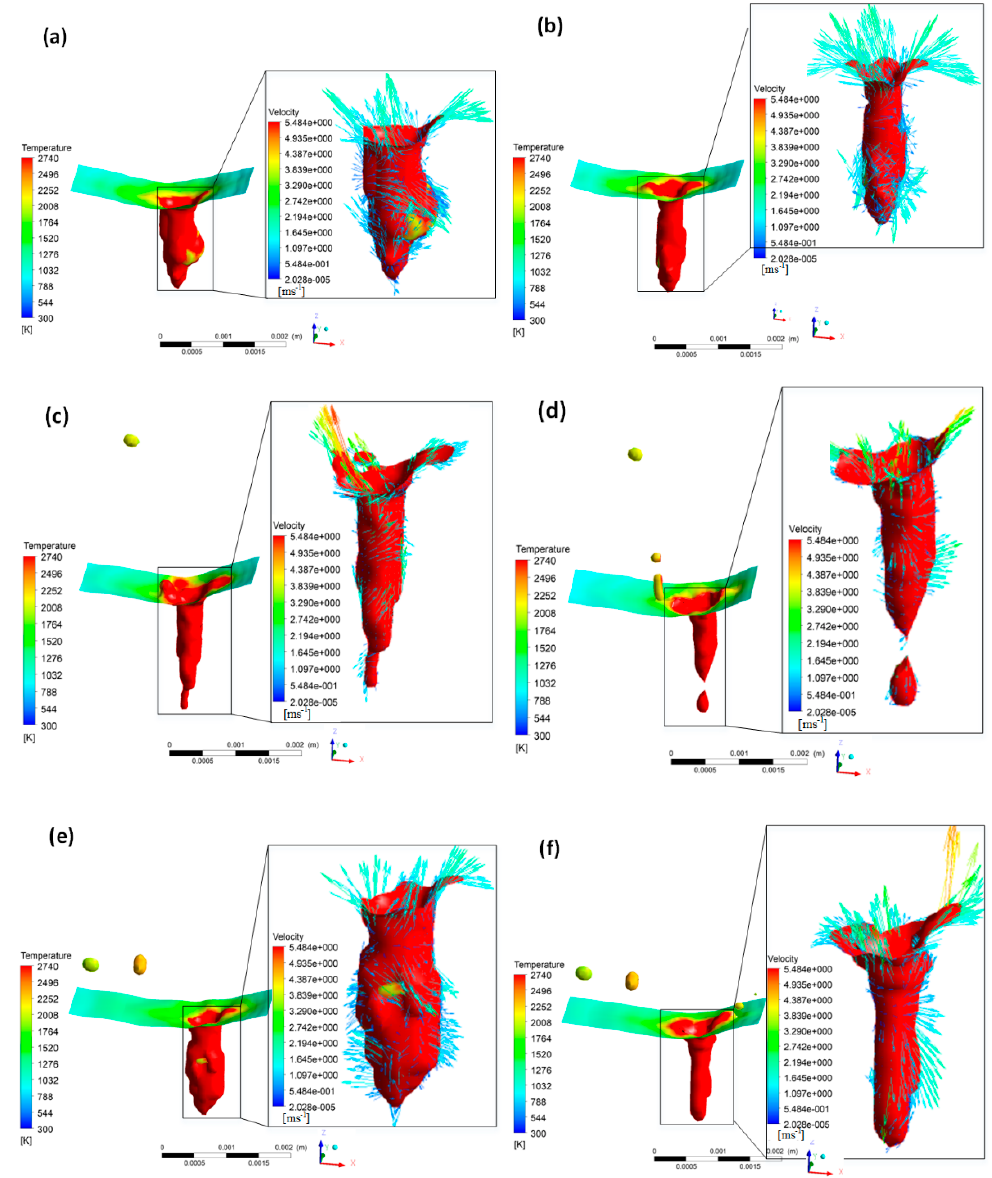
Figure 3. Three-dimensional transient behavior of the keyhole when the welding speed was 3 m/min: ( a ) t = 24 ms, ( b ) t = 25 ms, ( c ) t = 28.5 ms, ( d ) t = 28.8 ms, ( e ) t = 46.3 ms, ( f ) t = 46.8 ms.